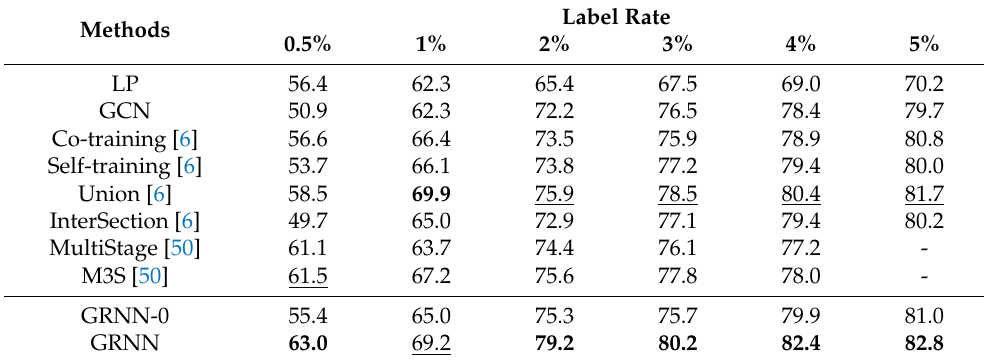
Table 4. Summary of classification accuracy (%) results with fewer training samples on Cora.